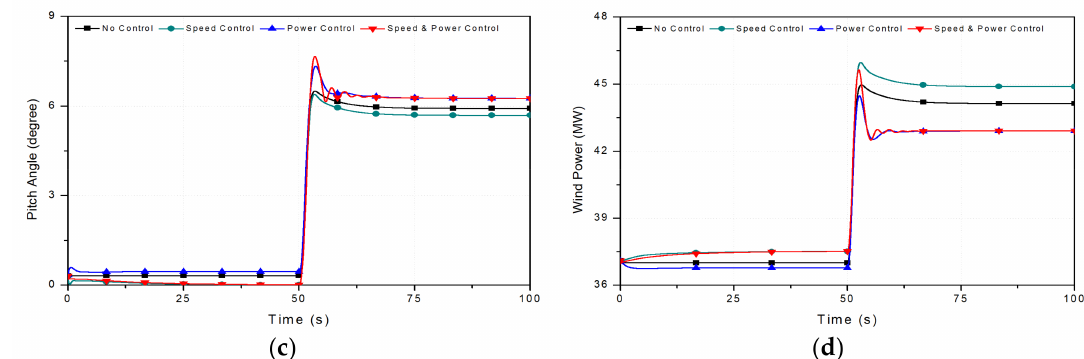
Figure 20. Simulation result when wind speed is increased (0~100 s): ( a ) Wind speed and loads; ( b ) Power reference; ( c ) Pitch angle; ( d ) Output of wind turbine.